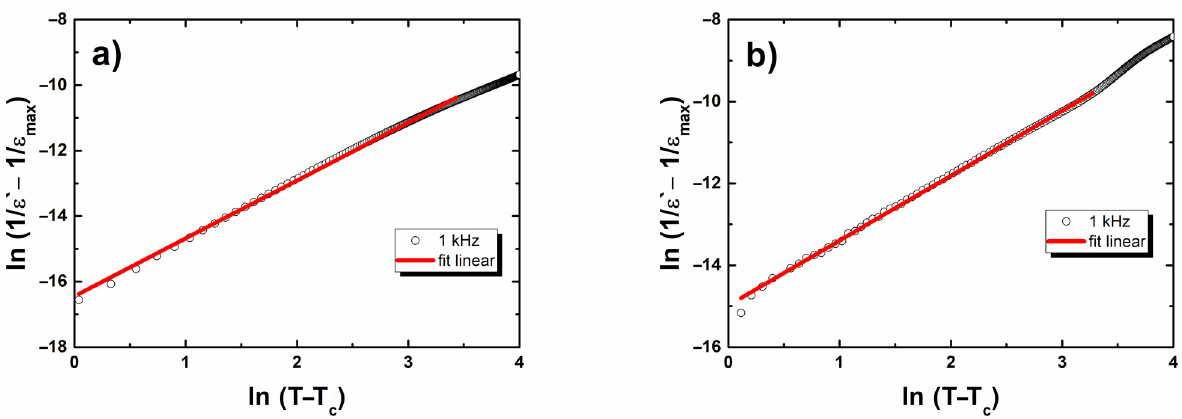
Figure 6. Log(1/ ε − 1/ ε max ) as a function of log( T − T ε max ) for BLT4 + Hf ( a ) and BLT4 + Hf + Eu ( b ) ceramics. The symbols represent experimental data and the solid line is fit to Equation (1).